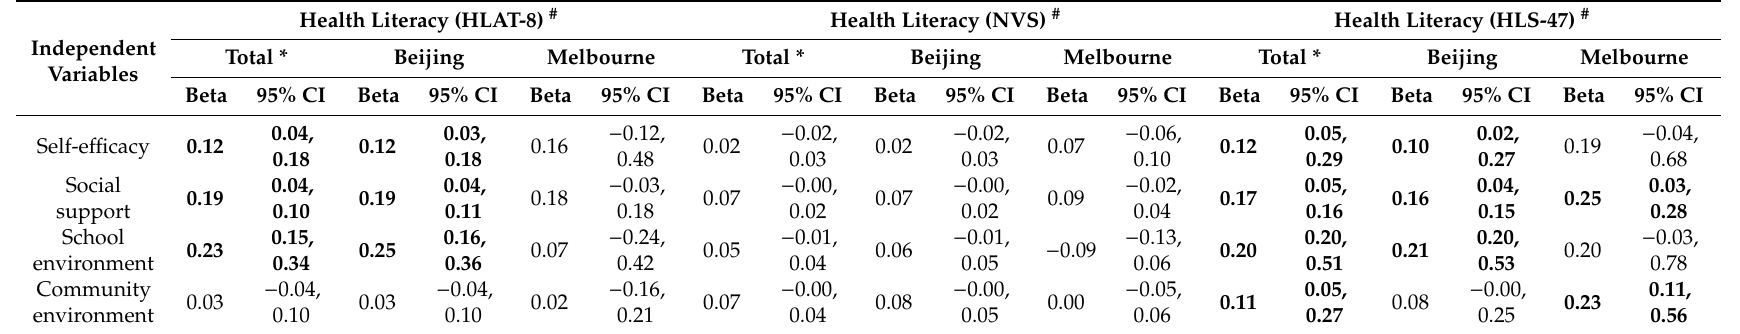
Table 3. Multiple linear regression models predicting health literacy according to di ff erent instruments.